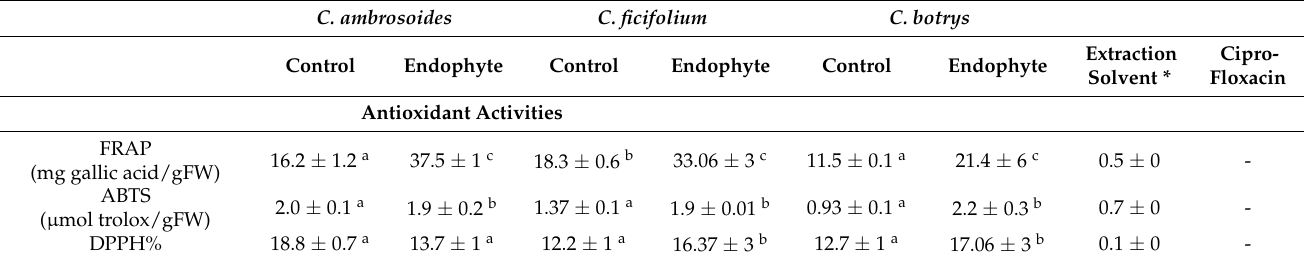
Table 5. Antioxidant activity of control and endophytic bacterial-treated Chenopodium ambrosoides, Chenopodium ficifolium, and Chenopodium botrys sprouts. Data are represented by the means of at least 3 replicates ± standard deviations. Different small letter superscripts (a, b, and c) within a row indicate significant differences between control and endophytic bacterial